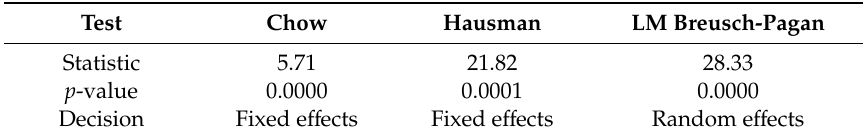
Table 8. Diagnostic tests to economic